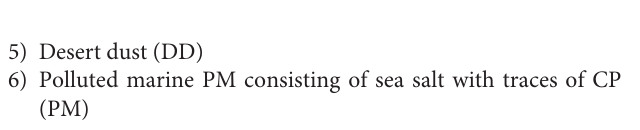
FIGURE 3 | A block flow chart for the aerosol retrieval from satellite measurements on a global